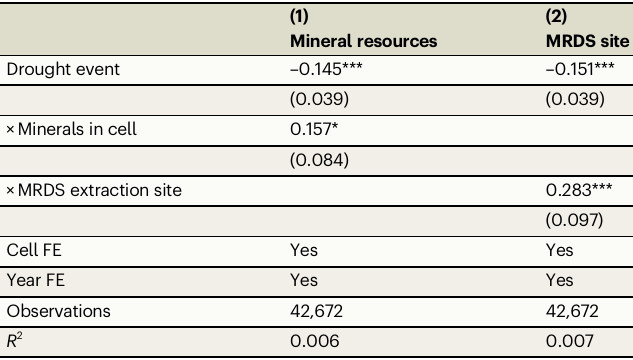
Table 3 | Effects of drought events on population: mineral resources as mediators